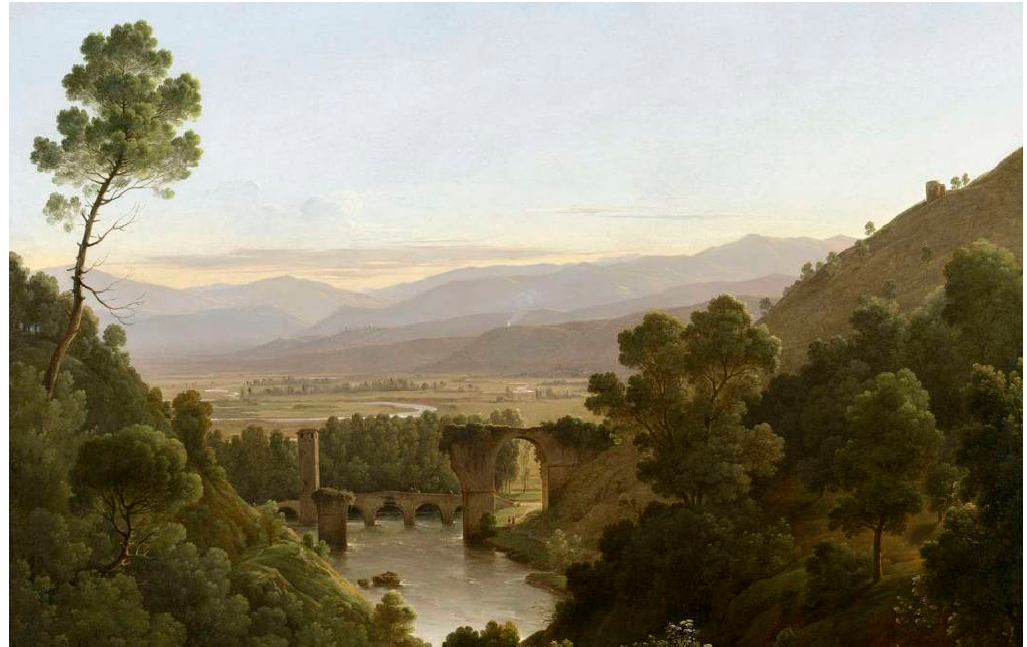
Figure 3. Pierre-Athanase Chauvin, La valle di Narni con le rovine del ponte di Augusto , 1813, Munich, Daxer & Marschall